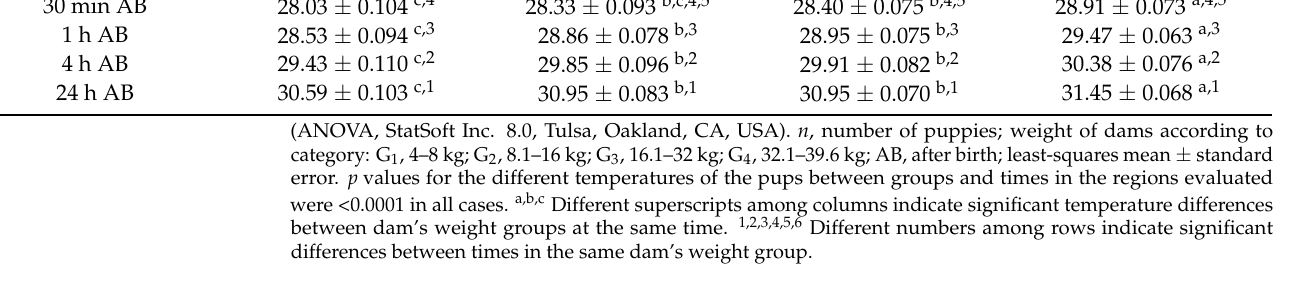
Table 2. Mean temperature ( ◦ C) of thoracic limb elbow (TLE) window at different times in newborn puppies from bitches classified into 4 groups according to its weight.